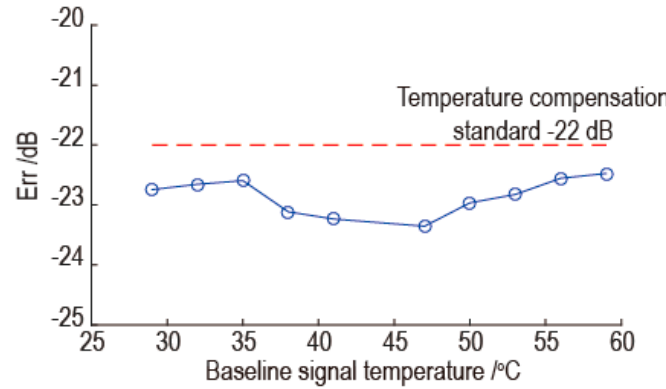
Figure 10. The worst temperature compensation results for each baseline signal for temperature interval 18 °C with the baseline signal temperature as the center.